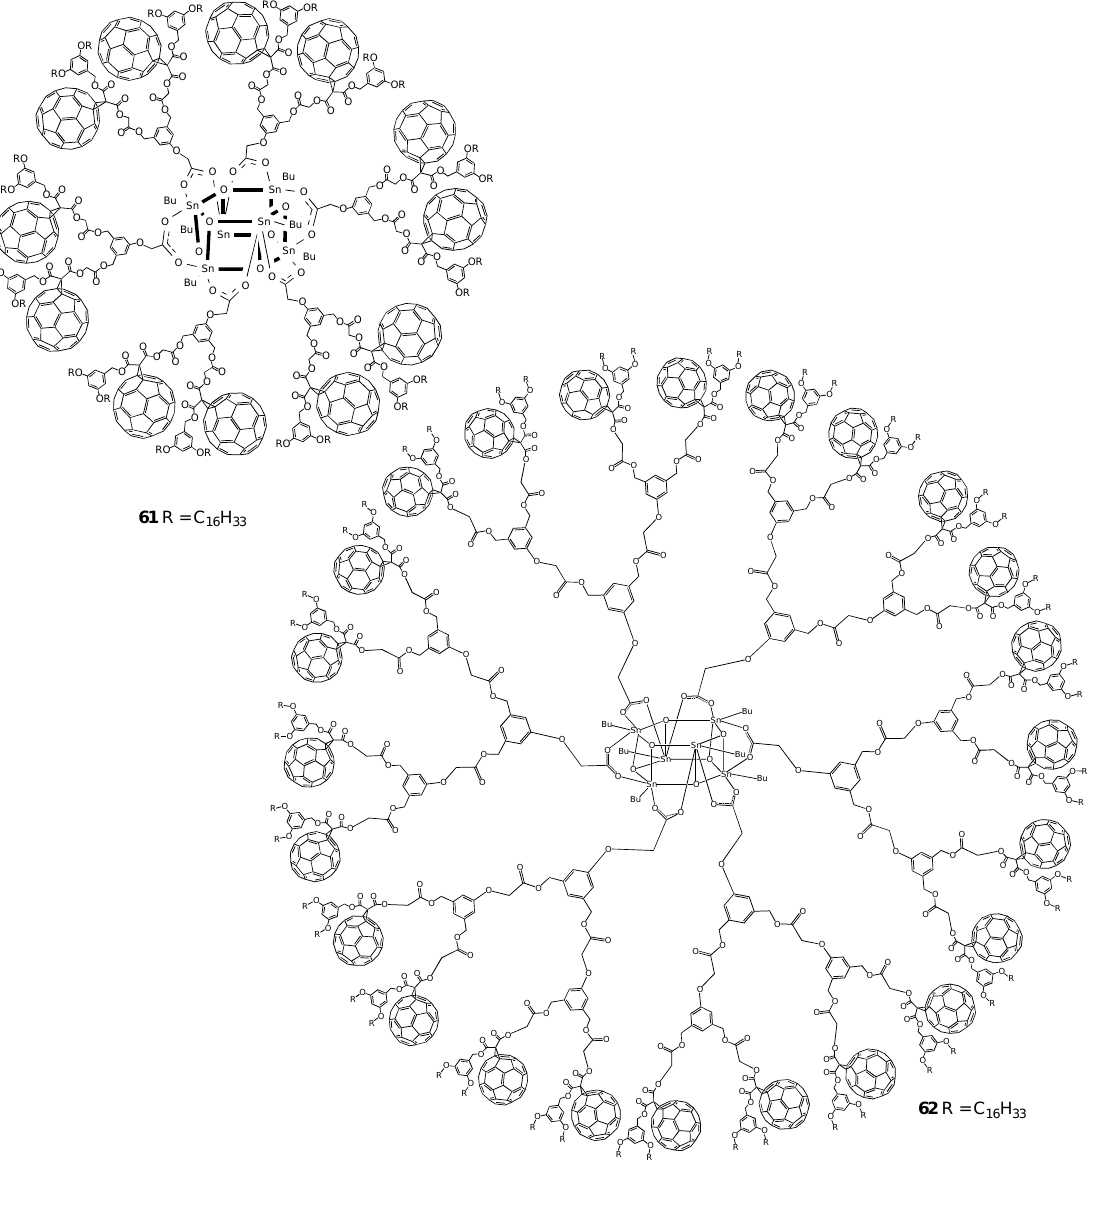
Figure 8. Fullerene-rich tin drum shaped clusters 61 - 62